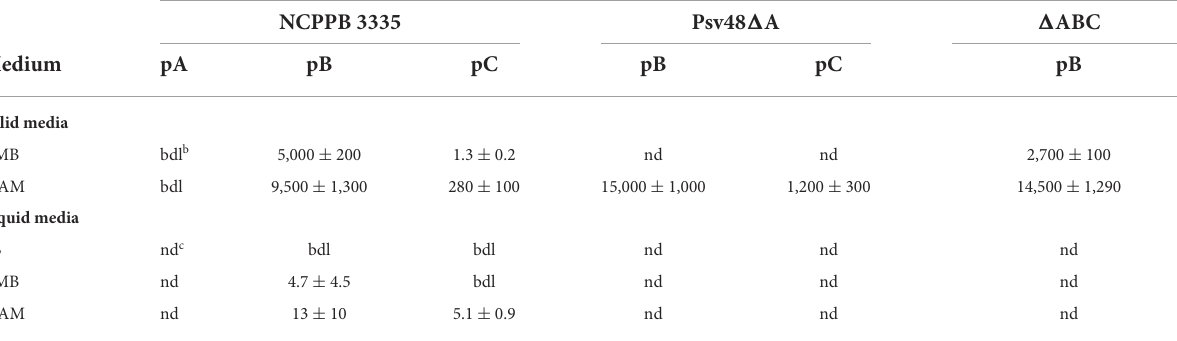
TABLE 1 Frequency of transfer of virulence plasmids from P. syringae pv. savastanoi NCPPB 3335 in solid and liquid media. Frequency of transfer for each plasmid ( × 10